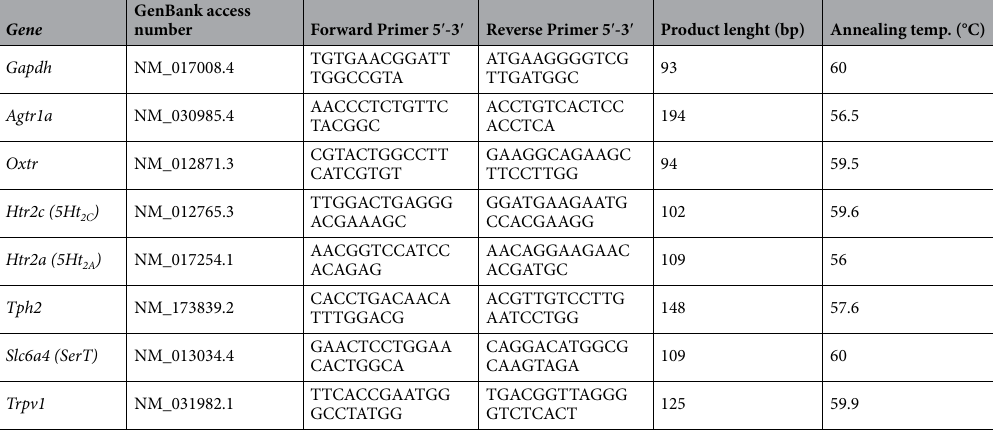
Table 1. Primers pairs for Gapdh, Agtr1a, Oxtr, Htr2a/2c,Tph2, Slc6a4 and